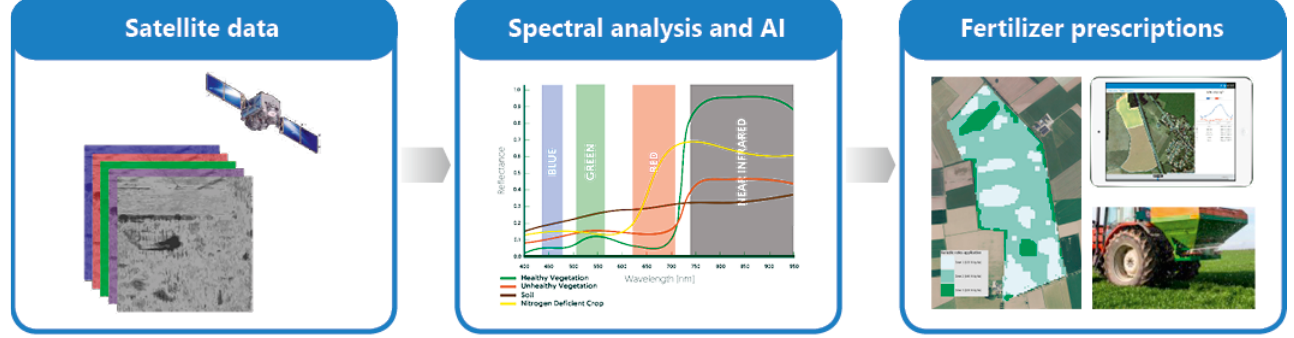
Figure 3. Impact example: Remote Sensing Pipeline (B1) application in farming (AI, artificial intelligence) to improve fertilizer application.